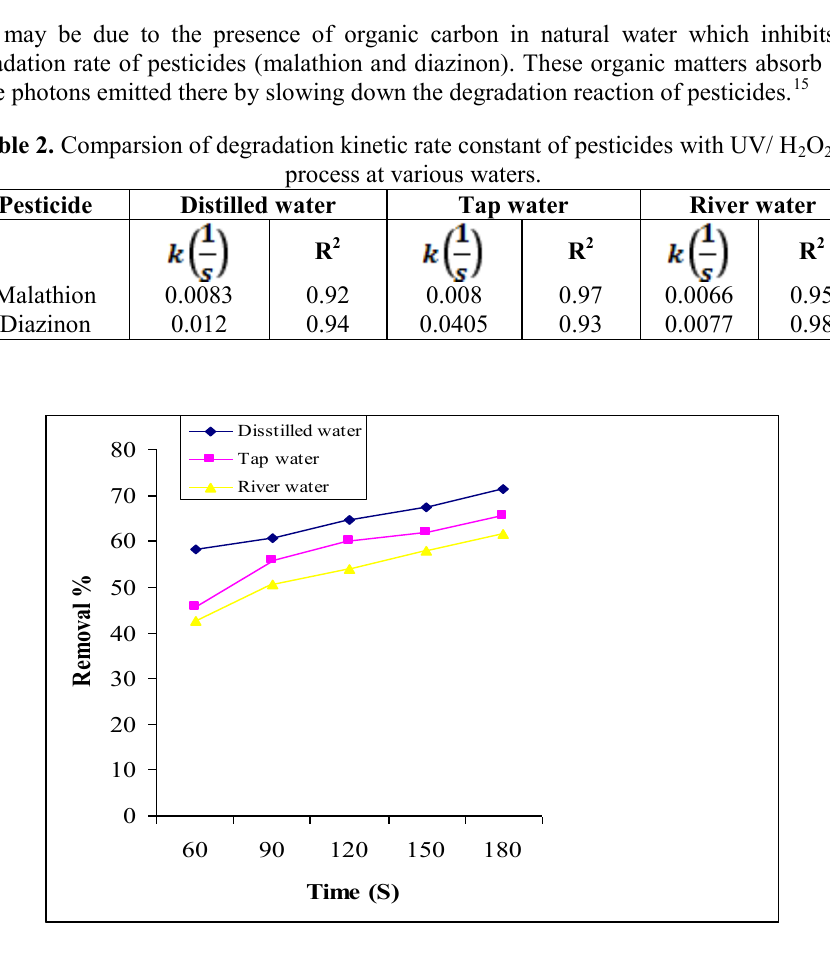
Figure 7 . Investigation the efficiency of UV/H